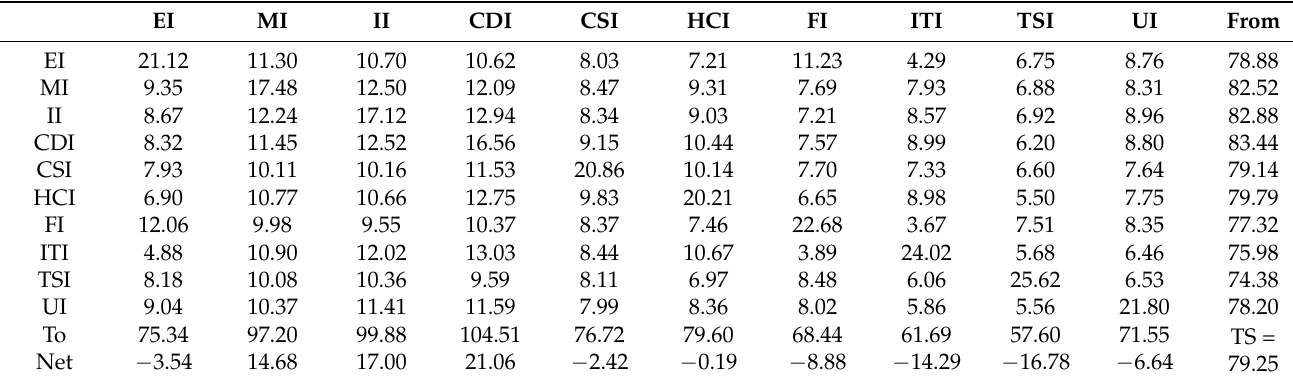
Table 3. Full sample financial shock transmission structure